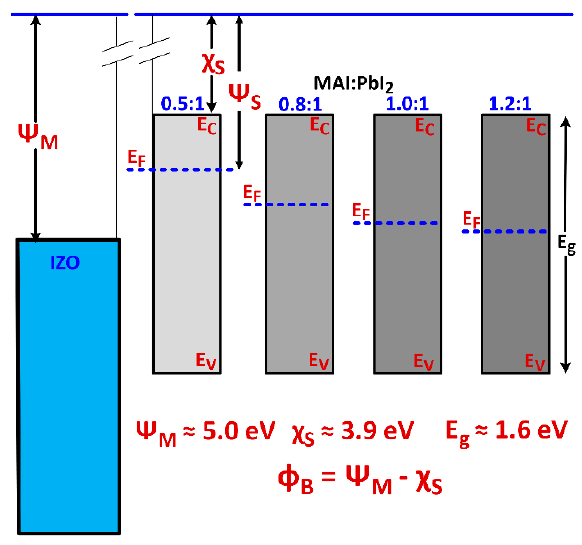
Figure 12. Band diagrams for the IZO and MAPbI 3 films of varying MAI / PbI 2 ratio. ψ m , ψ s , χ s , and E g are the metal (IZO) workfunction, semiconductor (MAPbI 3 ) workfunction, electron affinity of the MAPbI 3 , and band gap of the MAPbI 3 , respectively.